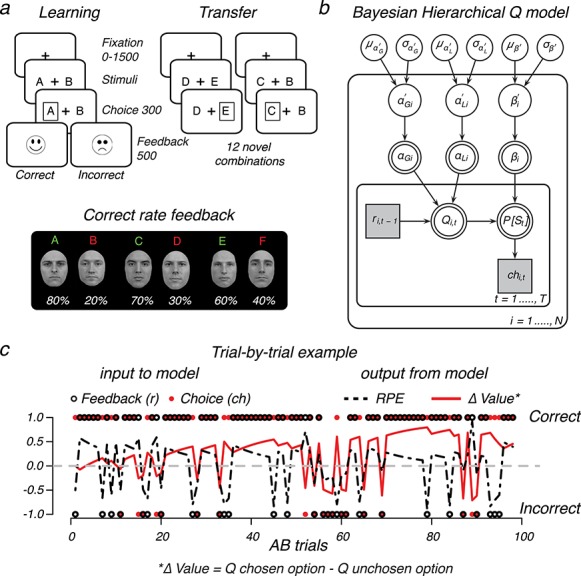
Design and Model. (a) Reinforcement learning task using faces. During learning, two faces were presented on each trial, and participants learned to select the optimal face identity (A, C, E) through probabilistic feedback (% of correct is shown beneath each stimulus). The learning phase contained three face pairs (AB, CD, and ED) for which feedback was given. In a follow-up transfer phase, these faces were rearranged into 12 novel combinations to assess learning. These trials were identical to learning trials, with the exception of feedback. (b) Graphical \documentclass[12pt]{minimal}
\usepackage{amsmath}
\usepackage{wasysym} 
\usepackage{amsfonts} 
\usepackage{amssymb} 
\usepackage{amsbsy}
\usepackage{upgreek}
\usepackage{mathrsfs}
\setlength{\oddsidemargin}{-69pt}
\begin{document}
}{}$Q$\end{document}-learning model with hierarchical Bayesian parameter estimation. The model consists of an outer subject (\documentclass[12pt]{minimal}
\usepackage{amsmath}
\usepackage{wasysym} 
\usepackage{amsfonts} 
\usepackage{amssymb} 
\usepackage{amsbsy}
\usepackage{upgreek}
\usepackage{mathrsfs}
\setlength{\oddsidemargin}{-69pt}
\begin{document}
}{}$i=1,\dots ..,N$\end{document}) and an inner trial plane (\documentclass[12pt]{minimal}
\usepackage{amsmath}
\usepackage{wasysym} 
\usepackage{amsfonts} 
\usepackage{amssymb} 
\usepackage{amsbsy}
\usepackage{upgreek}
\usepackage{mathrsfs}
\setlength{\oddsidemargin}{-69pt}
\begin{document}
}{}$t=1,\dots, T$\end{document}). Nodes represent variables of interest. Arrows are used to indicate dependencies between variables. Double borders indicate deterministic variables. Continuous variables are denoted with circular nodes and discrete with square nodes. Observed variables are shaded in gray (see Materials and Methods for details about the fitting procedure). (c) Illustration of the observed trial-by-trial input (i.e., the choice made and feedback received) and output (i.e., \documentclass[12pt]{minimal}
\usepackage{amsmath}
\usepackage{wasysym} 
\usepackage{amsfonts} 
\usepackage{amssymb} 
\usepackage{amsbsy}
\usepackage{upgreek}
\usepackage{mathrsfs}
\setlength{\oddsidemargin}{-69pt}
\begin{document}
}{}$Q$\end{document} for the chosen and unchosen stimulus, \documentclass[12pt]{minimal}
\usepackage{amsmath}
\usepackage{wasysym} 
\usepackage{amsfonts} 
\usepackage{amssymb} 
\usepackage{amsbsy}
\usepackage{upgreek}
\usepackage{mathrsfs}
\setlength{\oddsidemargin}{-69pt}
\begin{document}
}{}$\varDelta$\end{document}Value, and RPE) of the model given the estimated variability in learning rates from either positive (\documentclass[12pt]{minimal}
\usepackage{amsmath}
\usepackage{wasysym} 
\usepackage{amsfonts} 
\usepackage{amssymb} 
\usepackage{amsbsy}
\usepackage{upgreek}
\usepackage{mathrsfs}
\setlength{\oddsidemargin}{-69pt}
\begin{document}
}{}${\alpha}_{\mathrm{G}i}$\end{document}) or negative (\documentclass[12pt]{minimal}
\usepackage{amsmath}
\usepackage{wasysym} 
\usepackage{amsfonts} 
\usepackage{amssymb} 
\usepackage{amsbsy}
\usepackage{upgreek}
\usepackage{mathrsfs}
\setlength{\oddsidemargin}{-69pt}
\begin{document}
}{}${\alpha}_{\mathrm{L}i}$\end{document}) feedback and the tendency to exploit \documentclass[12pt]{minimal}
\usepackage{amsmath}
\usepackage{wasysym} 
\usepackage{amsfonts} 
\usepackage{amssymb} 
\usepackage{amsbsy}
\usepackage{upgreek}
\usepackage{mathrsfs}
\setlength{\oddsidemargin}{-69pt}
\begin{document}
}{}${\beta}_i$\end{document} higher values.